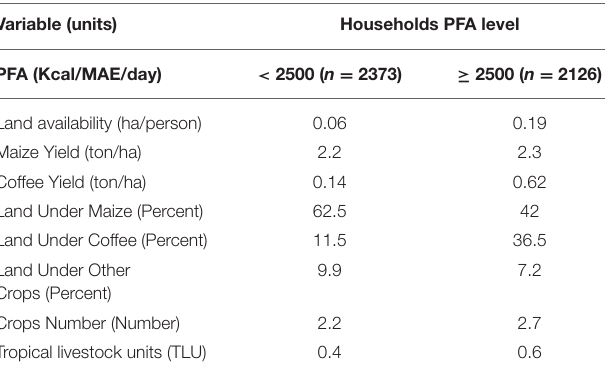
TABLE 2 | Differences in the predictor variables between the sampled households grouped into two, those whose PFA values are below 2500 kcal/day per MAE and those with PFA equal or above 2500 kcal/day per